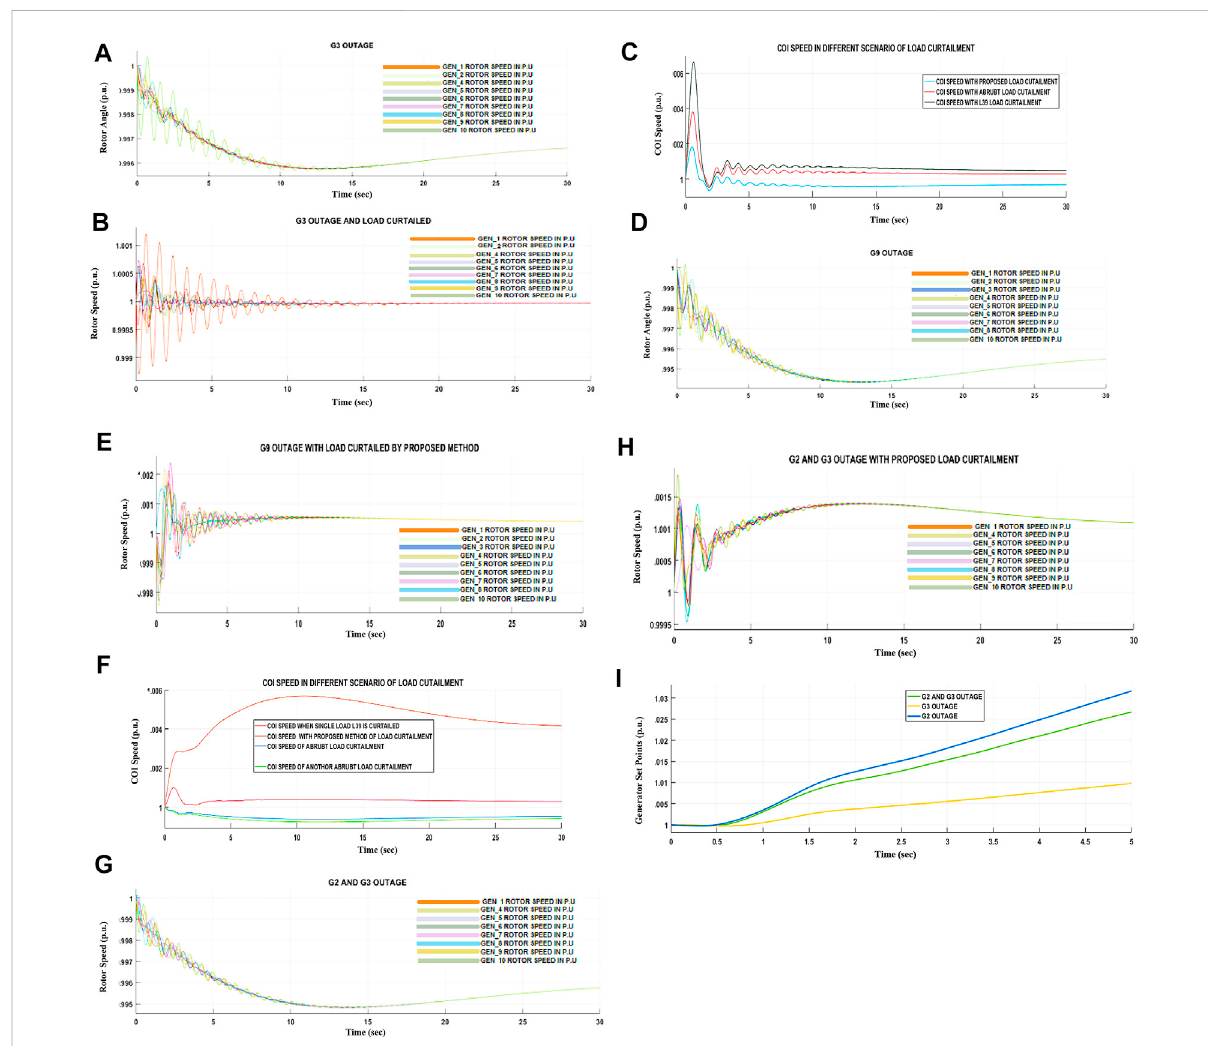
FIGURE 3 (A) RotorspeedofgeneratorincaseofG3outage. (B) RotorspeedofgeneratorincaseofG 3 outagewithproposedloadshedding. (C)